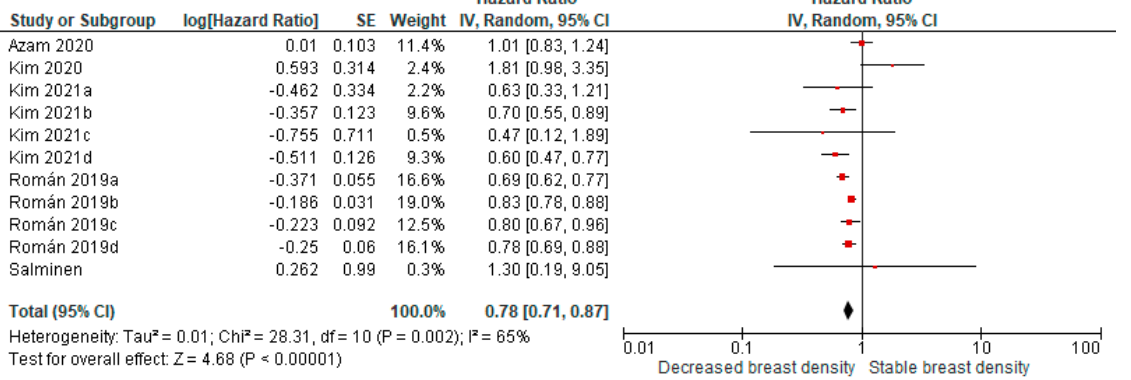
Figure 4. Pooled analysis for breast cancer risk in relation to decreased breast density over time (cohort studies). Kim